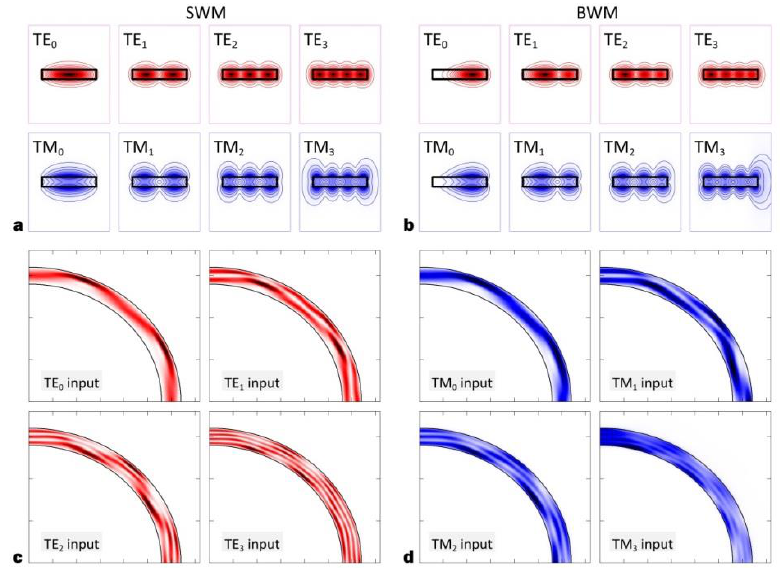
Figure 12. The calculated field profiles for ( a ) straight-waveguide mode (SWM) and ( b ) bent-waveguide mode (BWM). The calculated light propagation profiles for a 15-μm multi-mode bend when ( c ) TE 0–3 and ( d ) TM 0–3 modes are launched.